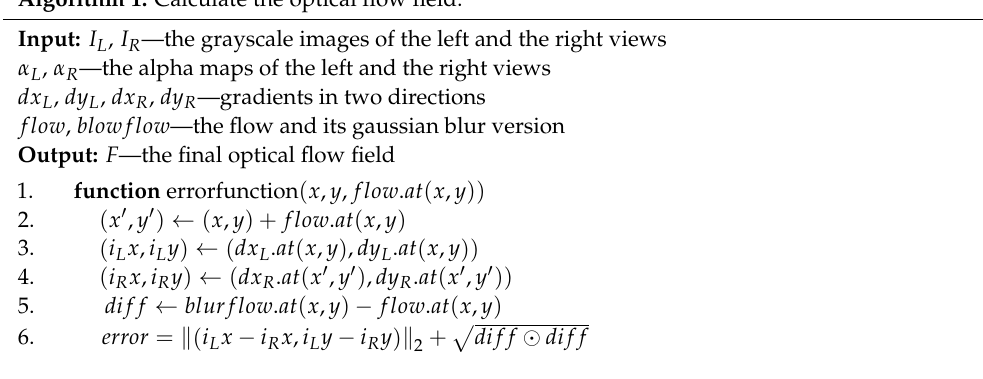
Algorithm 1. Calculate the optical flow